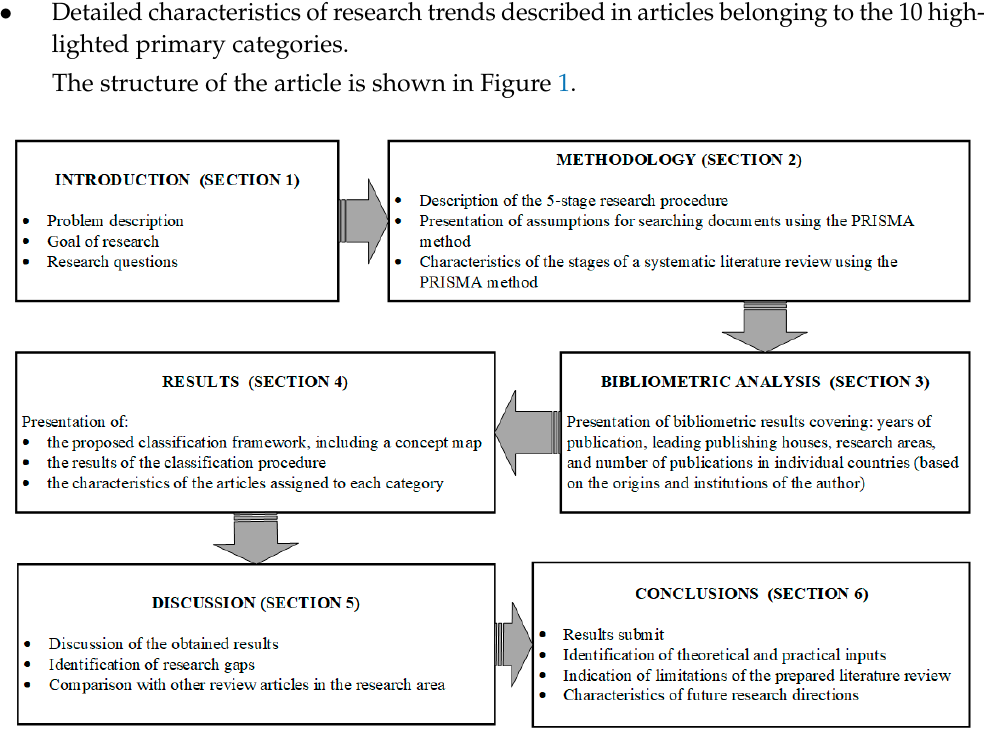
Figure 1. Structure of the